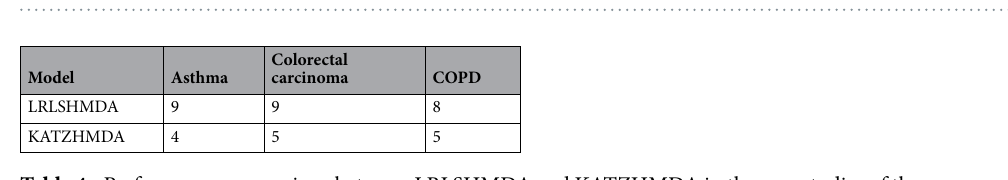
Table 3. In the case study of COPD, 8 out of top-10 predicted microbes have been supported by literature evidences.